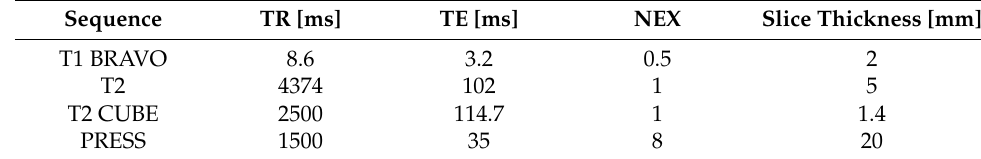
Table 1. Magnetic resonance imaging scan parameters used in the present